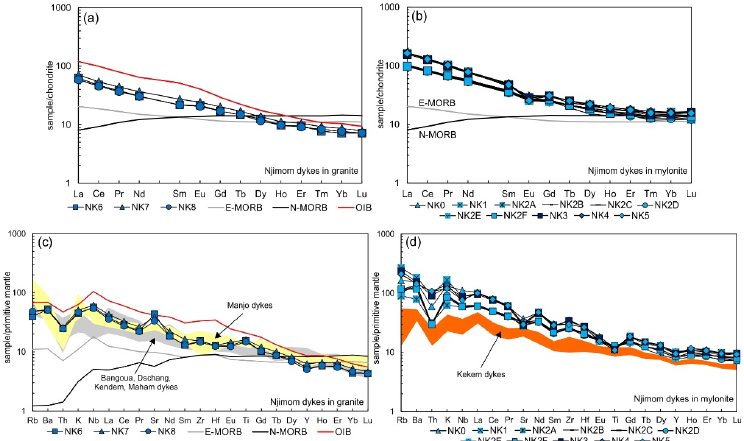
Figure 11. ( a , b ) Chondrite-normalized REE diagrams for Njimom dykes. The chondrite values used for normalization are those of [24]. Promethium is interpolated. N-MORB and E-MORB and OIB patterns are plotted with the values of [25]. ( c , d ) Primitive mantle-normalized incompatible element diagrams for Njimom dykes. Primitive mantle values are from [26]. Data from Manjo [6];